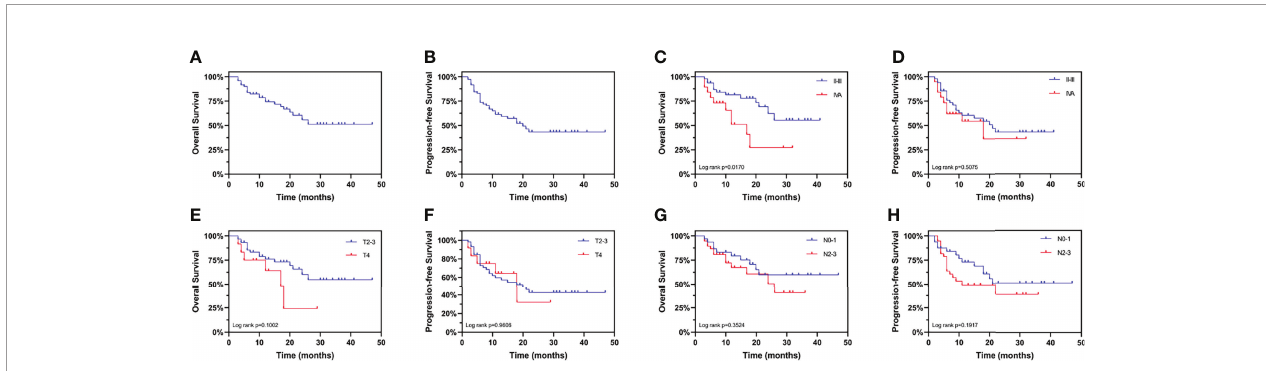
FIGURE 2 | Kaplan-Meier curves for overall survival and progression-free survival strati fi ed by clinical TNM stage. Curves are shown for overall survival in esophageal cancer patients (A) overall, (C) strati fi ed by clinical stage, (E) strati fi ed by clinical T stage, and (G) strati fi ed by clinical N stage. Curves are shown for progression-free survival in esophageal cancer patients (B) overall, (D) strati fi ed by clinical stage, (F) strati fi ed by clinical T stage, and (H) strati fi ed by clinical N